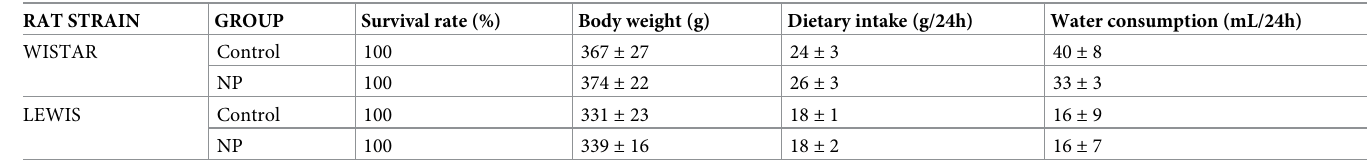
Table 1. General parameters: Survival rate (%), body weight (g), dietary daily intake (g/24h) and water consumption (mL/24h) of each experimental group.